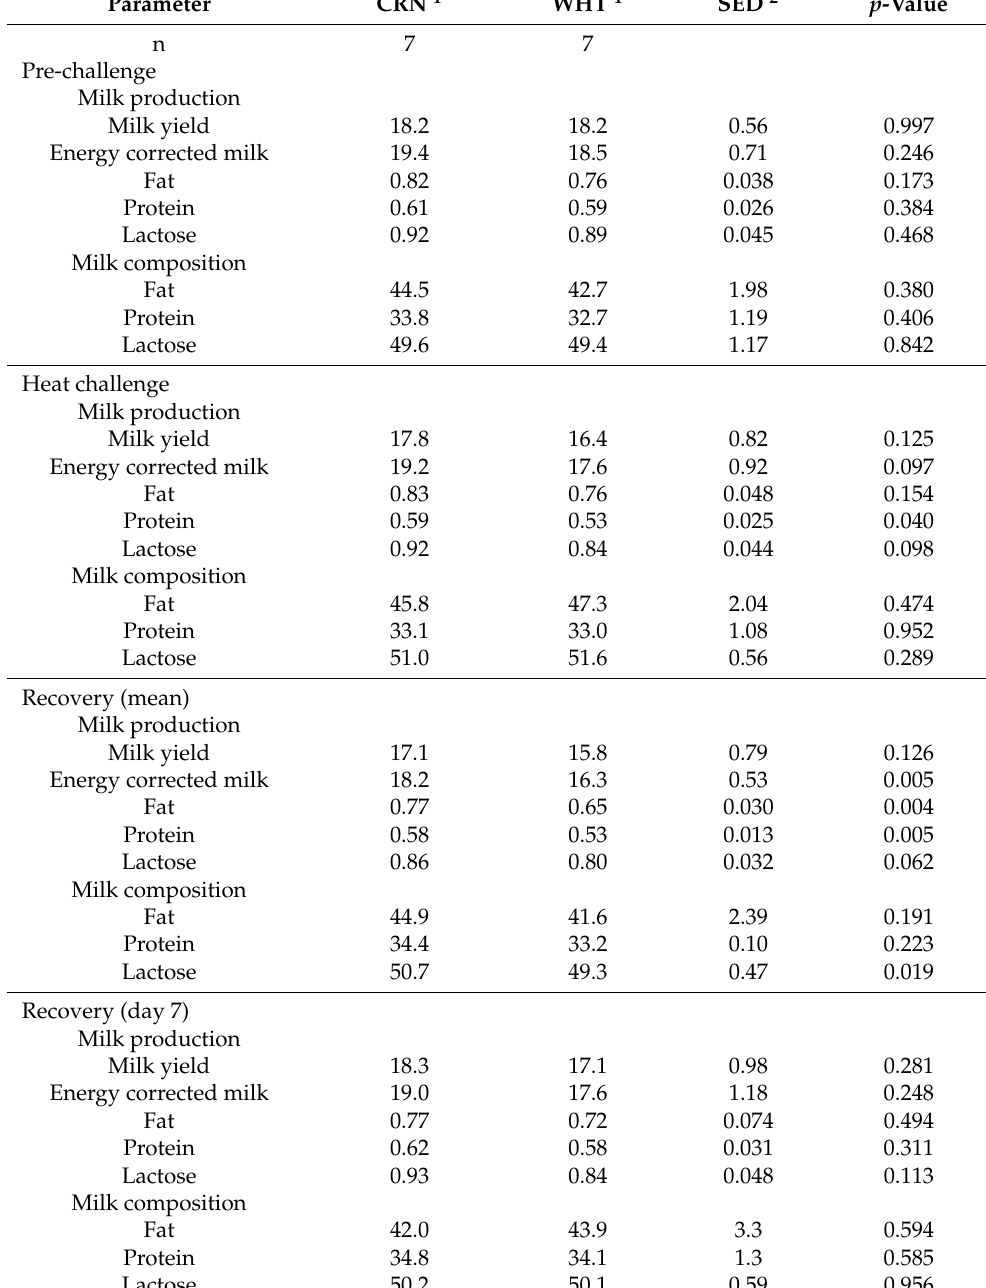
Table 3. Mean milk yield (kg/day) and composition (g/kg) during each period of the experiment, and on day 7 of the recovery